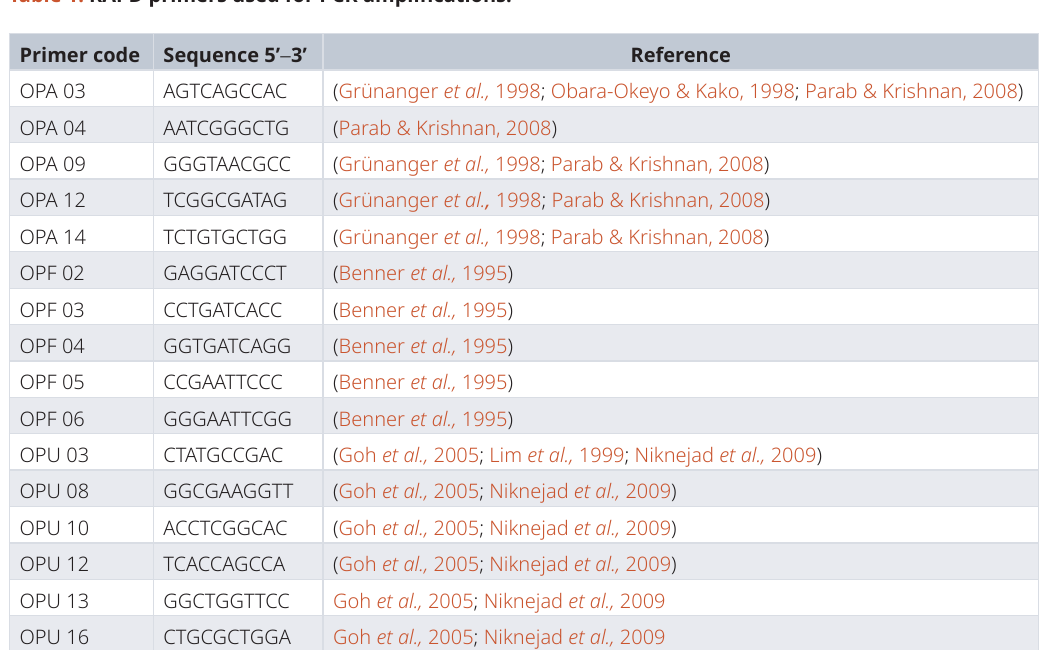
Table 1, were used to amplify the DNA samples of the three Malaysian endemic Coelogyne species. These sequences were obtained from published articles (Table 1) where they have been used successfully in other orchid species. The RAPD amplifi- cation reactions were performed in a 10 μl volume containing